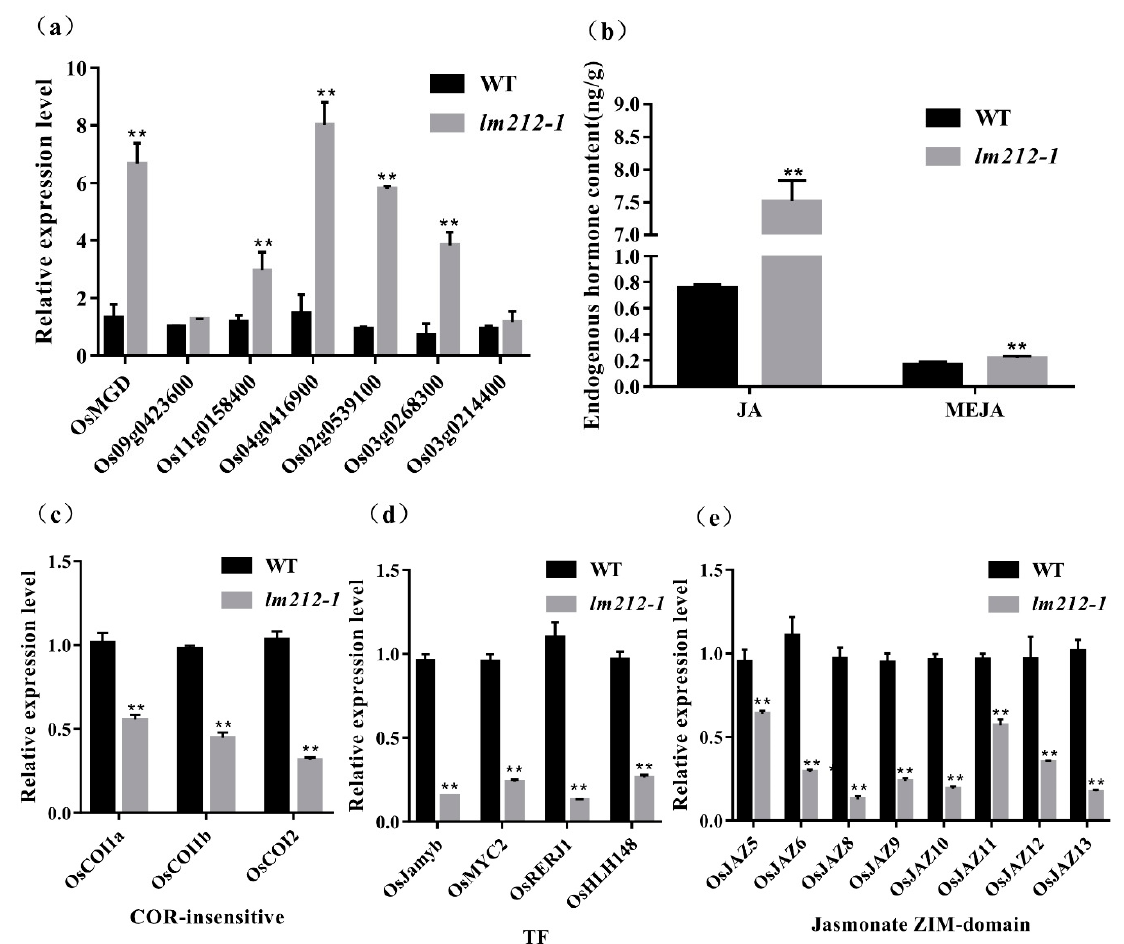
Figure 7. Detection of MGDG and JA-related pathway and contents of JA. ( a ) Expression analysis of MGDG synthesis-related genes in WT and lm212-1 at the tillering stage. ( b ) Contents of JA and MeJA in WT and lm212-1 at the tillering stage. ( c – e ) Expression analysis of three types of genes in the JA signal pathway. ( c ) The COR-insensitive pathway, ( d ) the TF pathway, ( e ) the jasmonate ZIM-domain pathway. ** p < 0.01 by the Student’s t -test. Data represent means ± SD of three biological replicates in ( a , c , d ). Data represent means ± SD of four biological replicates in ( b ).